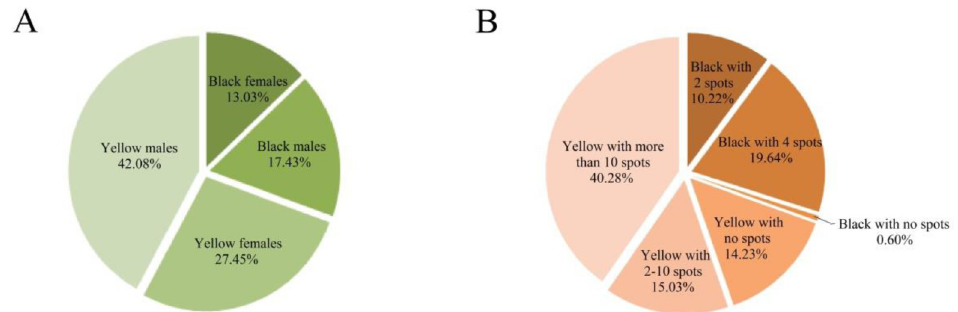
Fig 2. Relative distribution of elytral colours and patterns in the H . axyridis population (in late March and early April of 2014). (A) Distribution of elytral colour by sex. (B) Distribution by elytral colour and spot number.